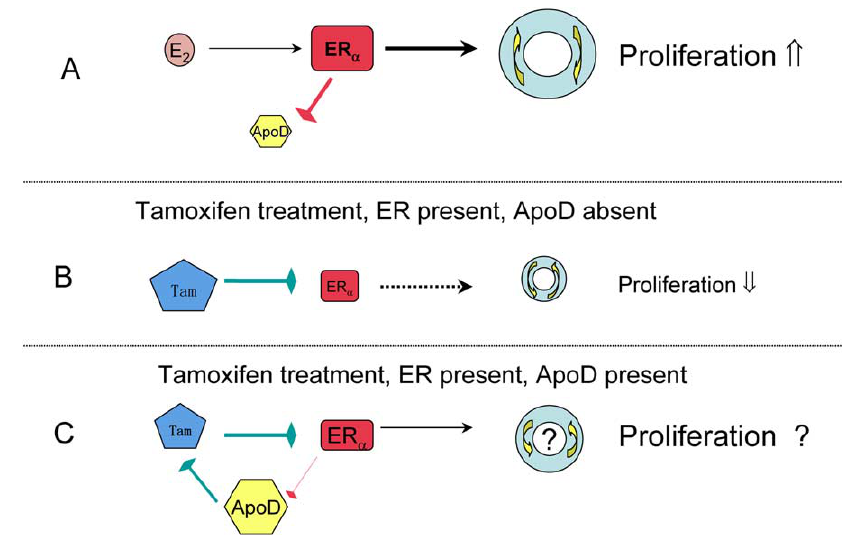
Fig. 7. The triangular relationship between tamoxifen, ER and ApoD. (A) ER has a stimulatuory effect ( ) on the cell proliferation, and an inhibitory effect ( ) on ApoD transcription. (B) Administration of tamoxifen will inhibit ( ) ER action and reduce proliferation. (C) In ApoD positive cells, the ER is either not functional and will not exert its potent inhibitory effect on ApoD transcription or tamoxifen will increase ApoD transcription by reducing the inhibitory ER effect ( ). ApoD may in turn bind and chelate tamoxifen ( ). In either case, tamoxifen will probably not have the same antiproliferative effect compared with a ApoD negative cell. Abbreviations: ApoD: Apolipoprotein D;